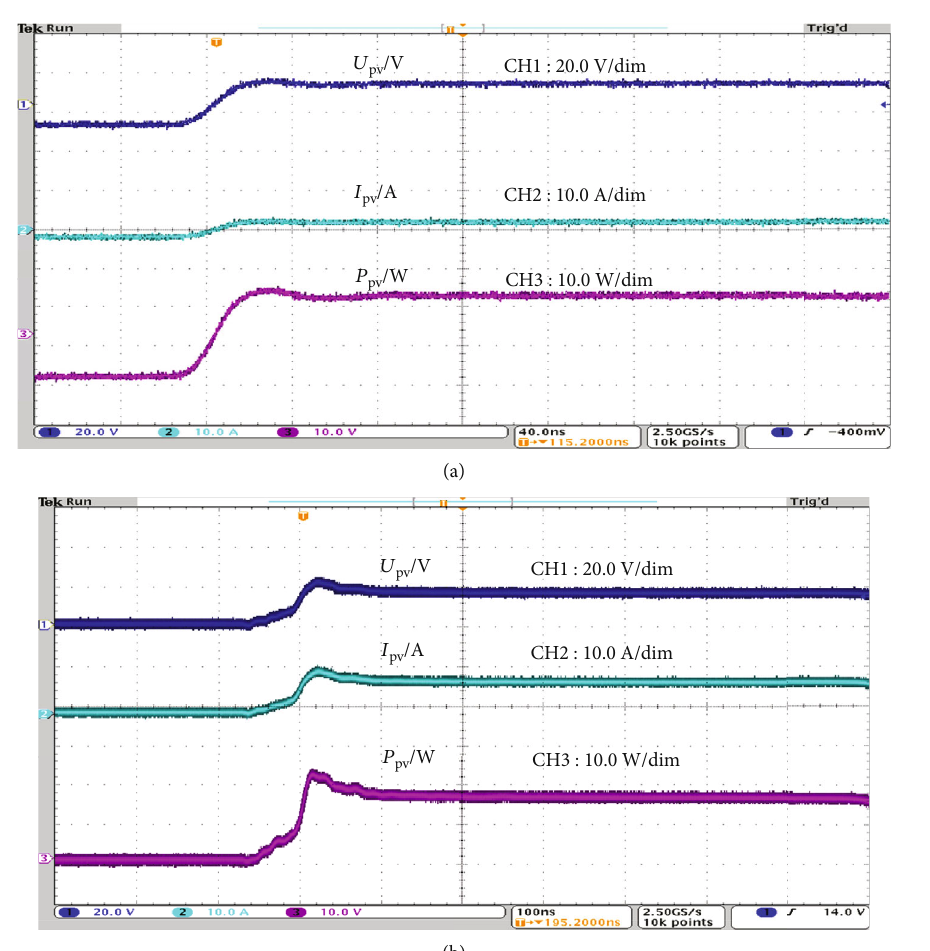
Figure 21: Tracking results under varying G (a) FA-EAS-ElmanNN algorithm and (b) PSO